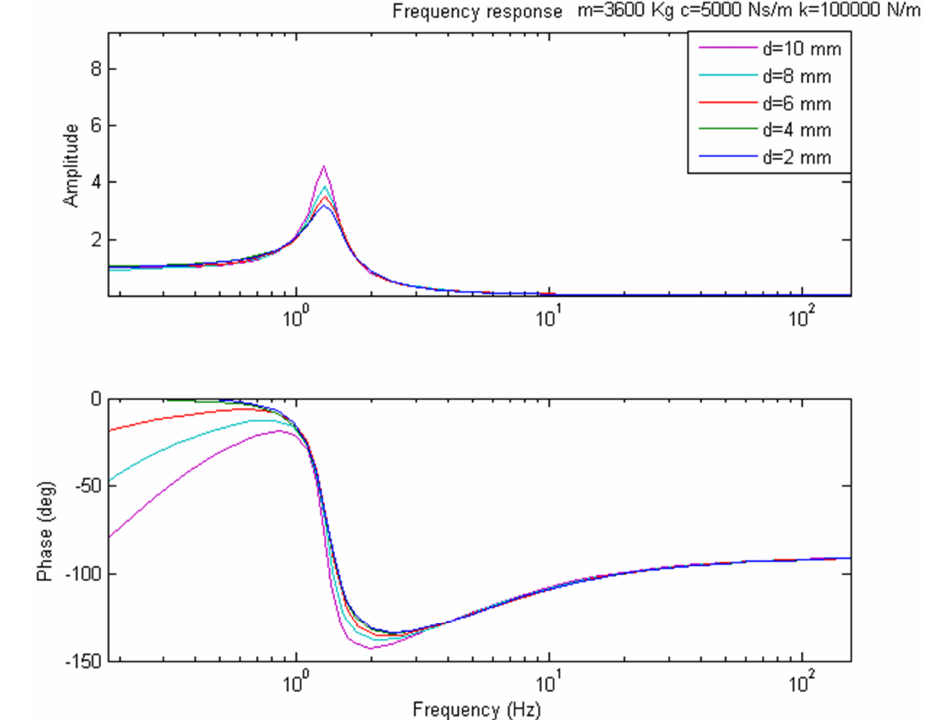
Рис . 8 – Передаточная функция вертикального смещения при различныхдиаметрах клапан